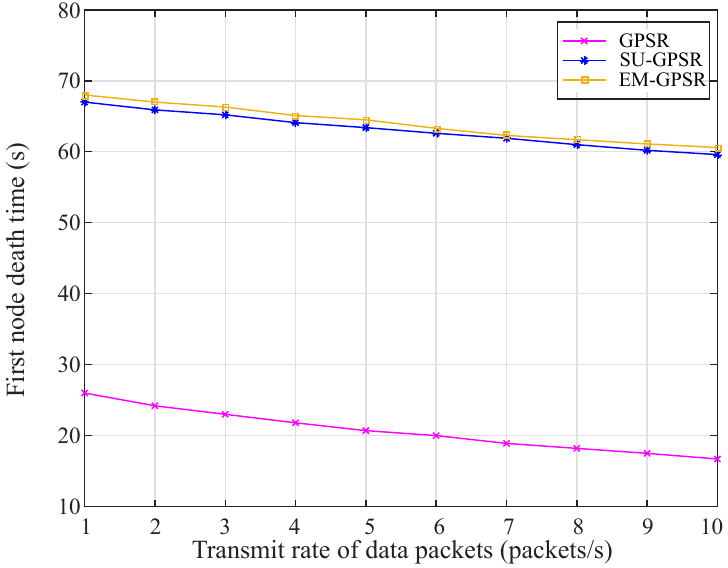
Figure 14. First node death time versus transmit rate of data